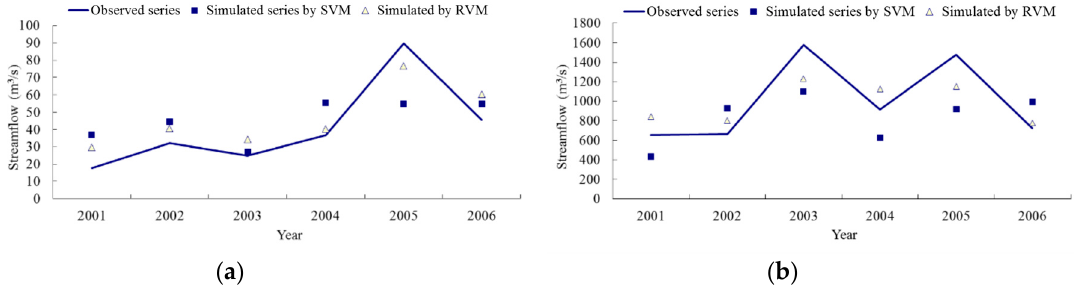
Figure 4. Observed and simulated streamflow data in the Dahuofang Reservoir ( a ) and Danjiangkou Reservoir ( b ) during the testing period by the RVM and SVM model.